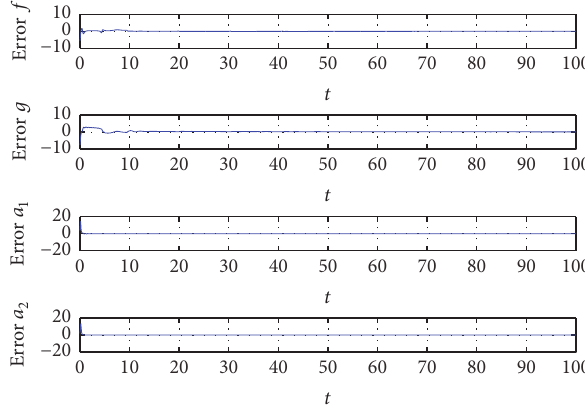
Figure 3: Time series of error states.